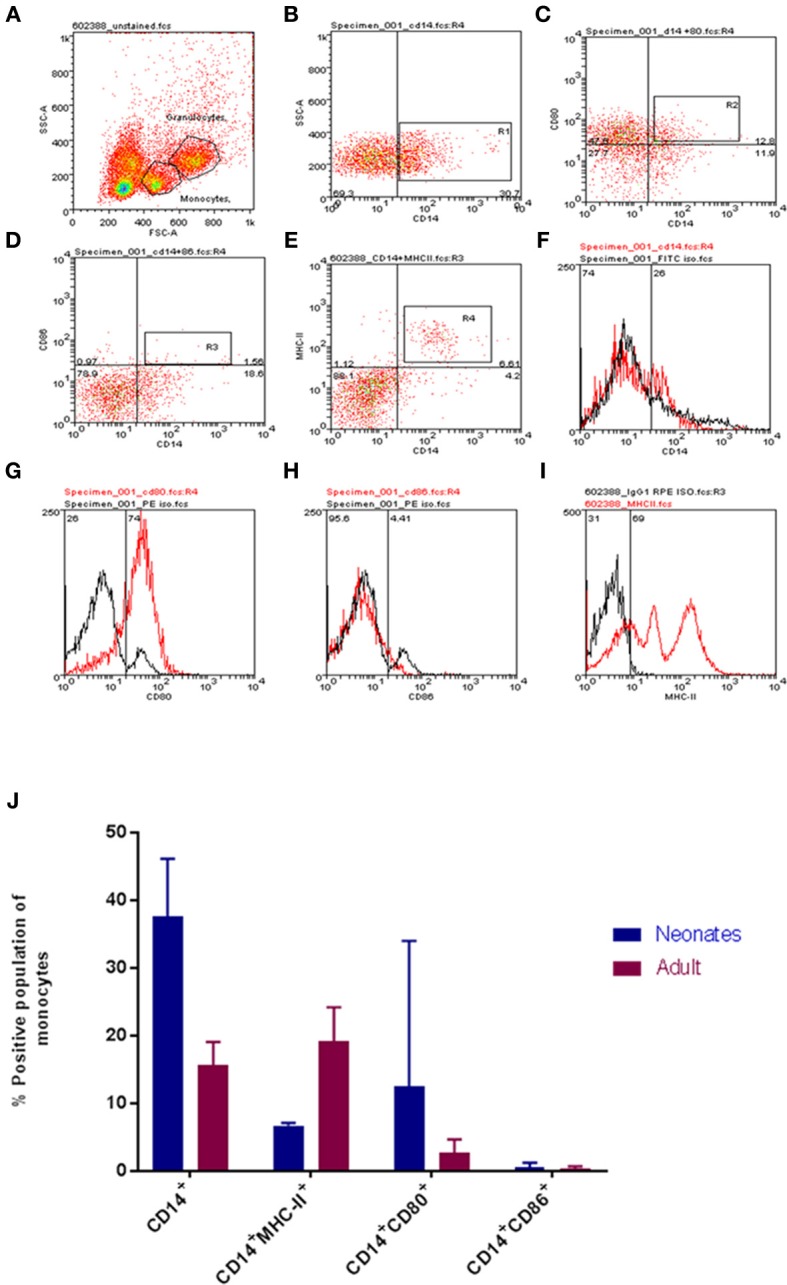
Age-dependent differences in bovine monocyte proportions and phenotypes. Representative gating for neonatal and adult leukocytes is shown. Cells were identified on FSC vs. SSC dot plot (A), then CD14 positive cells (B), CD14CD80 dual staining (C), CD14 CD86 dual staining (D), CD14 MHCII dual staining (E), isotype controls for CD14, CD80, CD86, and MHCII are shown in (F–I). (J) The proportions of defined cell populations are presented for both age groups. Cell populations presented are CD14+; CD14+MHC-II+; CD14+CD80+; and CD14+CD86+. Our analysis revealed a larger total population of CD14+ monocytes and CD14+CD80+ expressing monocytes within calves; while adults harbored a larger population of CD14+MHC-II+ monocytes. The bars show mean ± SEM of adult and young samples (N = 3 and 4 per group, respectively). Results were analyzed using GraphPad Prism 7.02 and statistical analysis was performed out by Mann Whitney test to compare the means of defined populations between age groups; *indicates a P-value < 0.05.